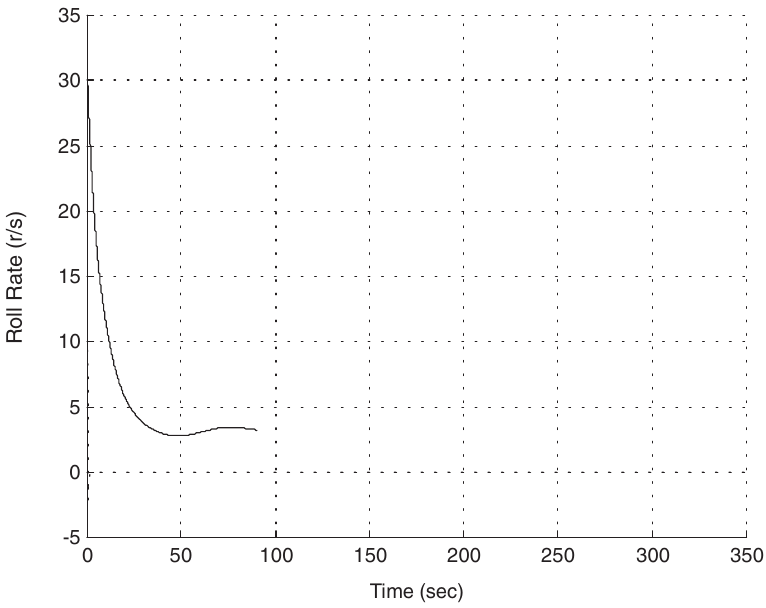
Fig. 10. Roll rate vs. time (Solid = Nominal, Dotted =